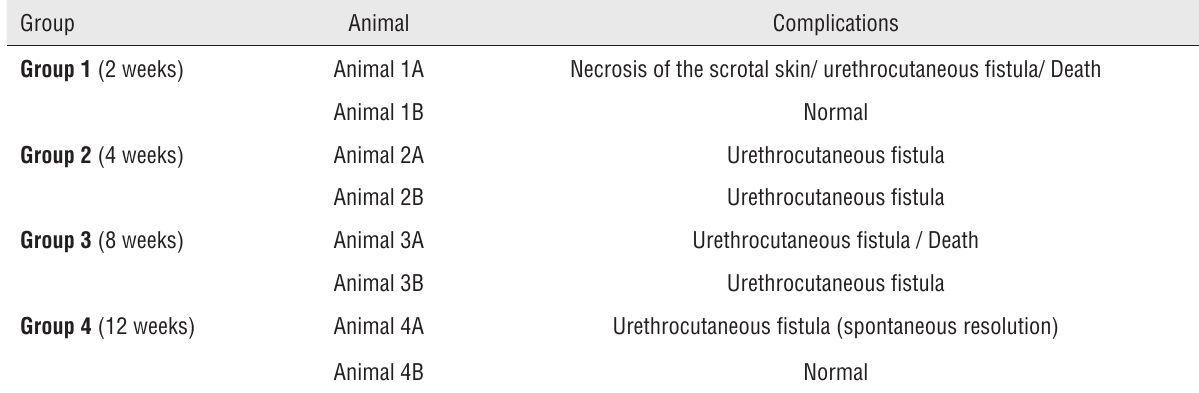
Table 1 - Description of surgical